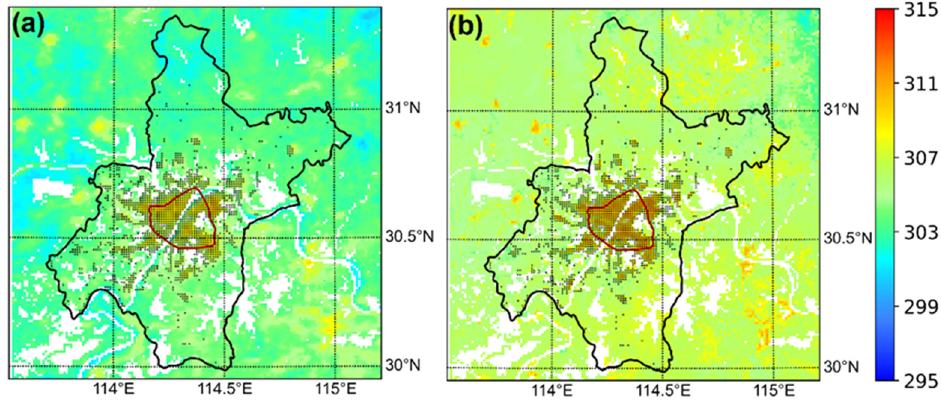
Figure 5. The spatial distribution of LST for MODIS ( a ) and u-HRLDAS ( b ), averaged from 1 August 2013 to 15 August 2013 (the black points represents the urban grid).